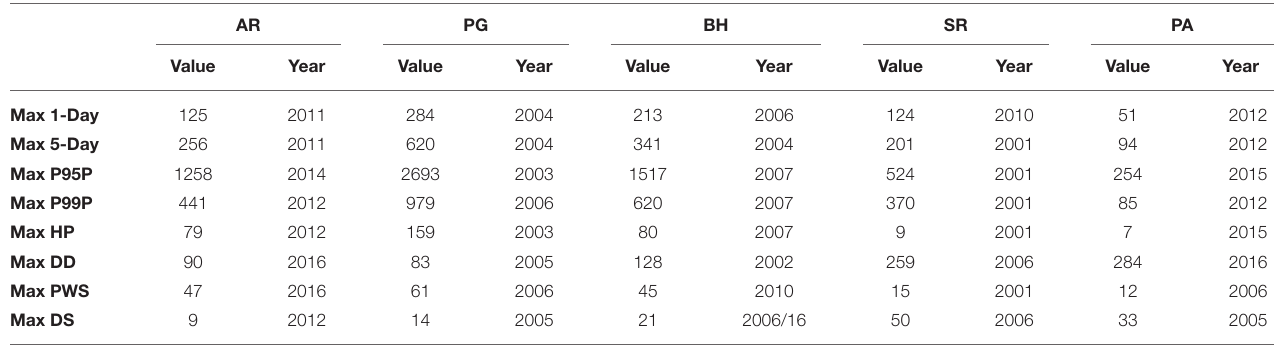
TABLE 4 | Indices of precipitation extremes.